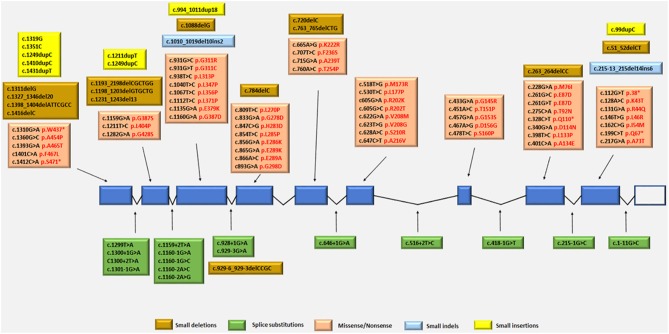
Pathogenic TYMP gene mutations (NM_001113755.2; NP_001107227) in exonic and intronic regions. Protein changes, where known are indicated in red font.